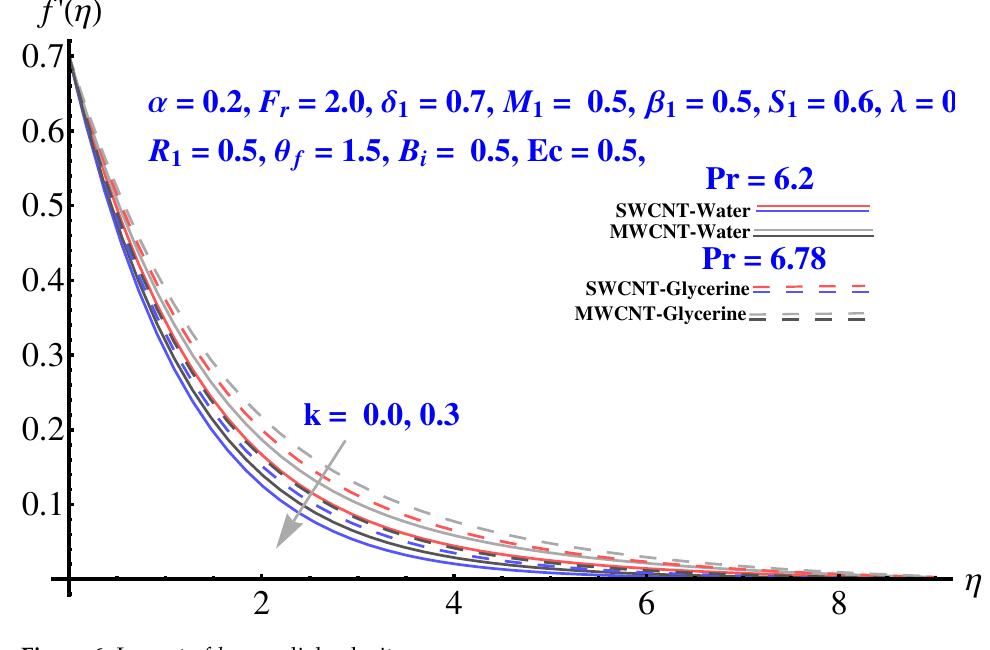
Figure 6. Impact of k on radial